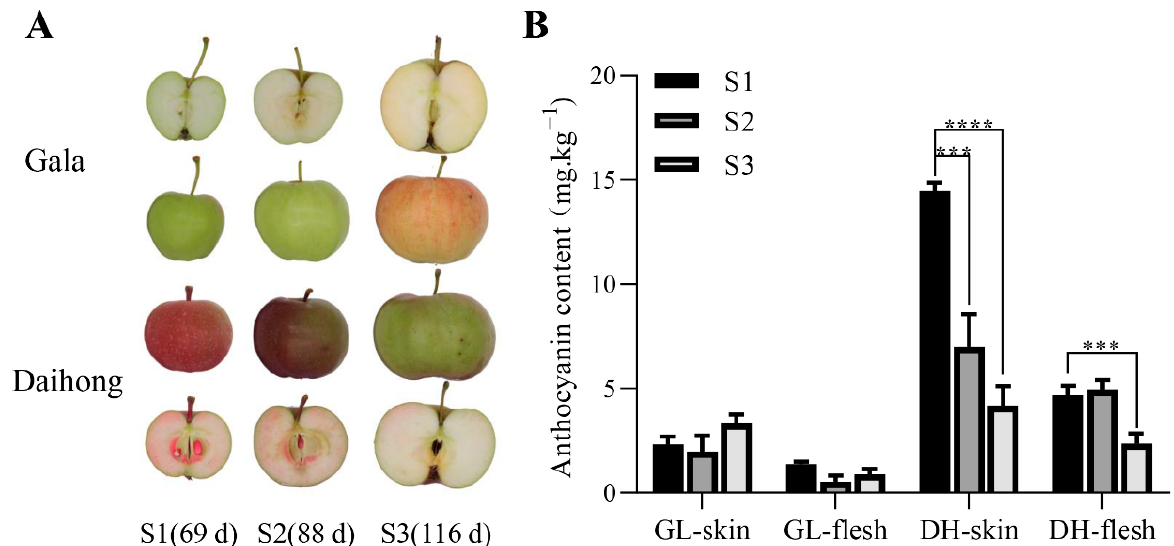
Figure 1. The phenotypes and anthocyanin contents of ‘Gala’ and ‘Daihong’ apples at different stages of growth. ( A ): Color changes in the skin and flesh of ‘Gala’ (GL) and ‘Daihong’ (DH) apples during the S1, S2, and S3 stages of fruit development. ( B ): Anthocyanin contents of the skin and flesh of ‘Gala’ and ‘Daihong’ apples during the S1, S2, and S3 stages. The bars represent means ± SD ( n = 3). Asterisks indicate statistically significant differences (*** p < 0.001; **** p < 0.0001).